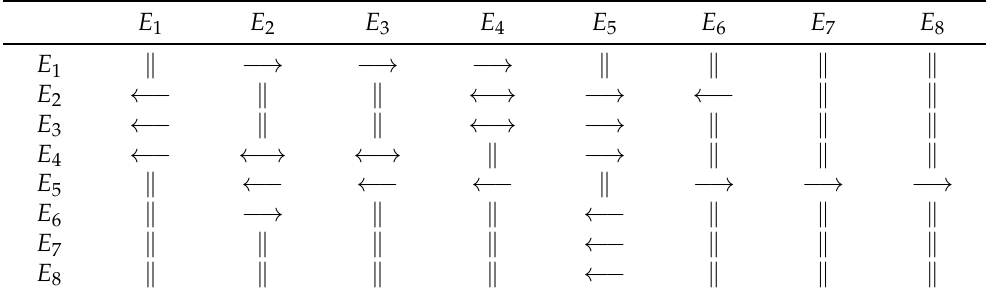
Table 1. EST for our log file example.